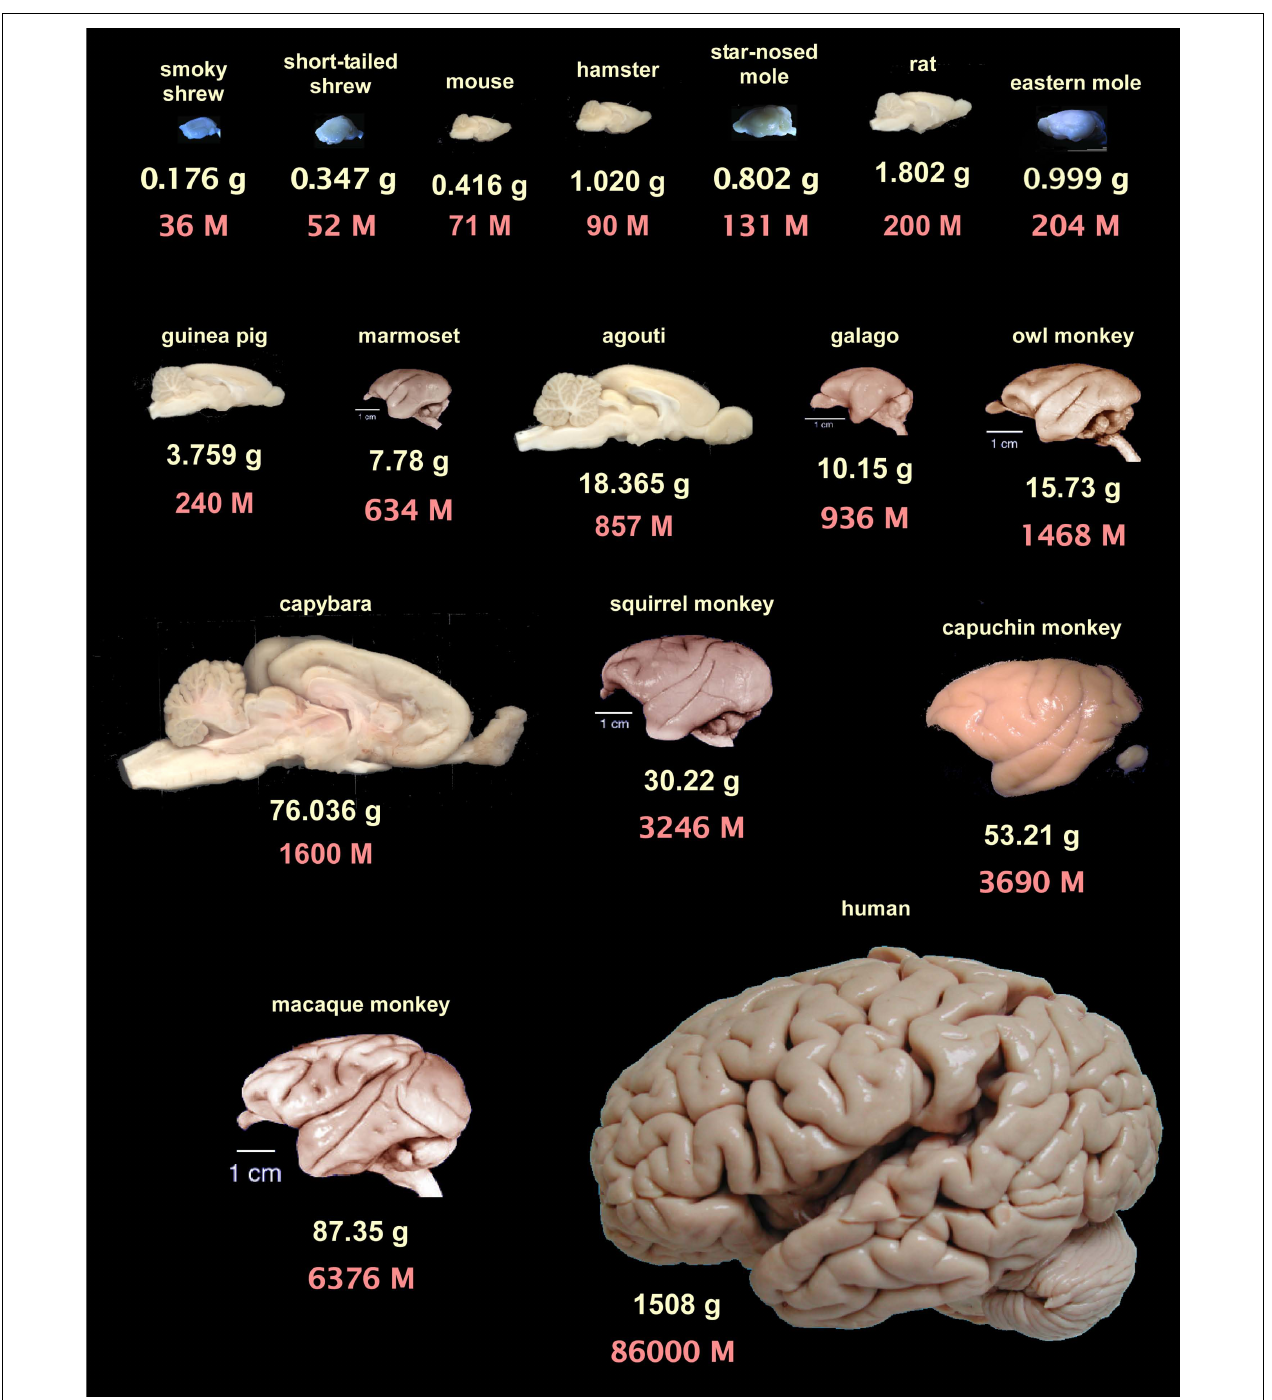
FIGURE 3 | Brain mass and total number of neurons for the mammalian species examined so far with the isotropic fractionator. Brains are arranged from left to right, top to bottom, in order of increasing number of neurons according to average species values from Herculano-Houzel et al., 2006 (rodents), Herculano-Houzel et al., 2007 (non-human primates), Sarko et al., 2009 (insectivores) and Azevedo et al., 2009 (human brain). Rodent brains face right, primate brains face left, insectivore brains can be identifi ed in the fi gure by